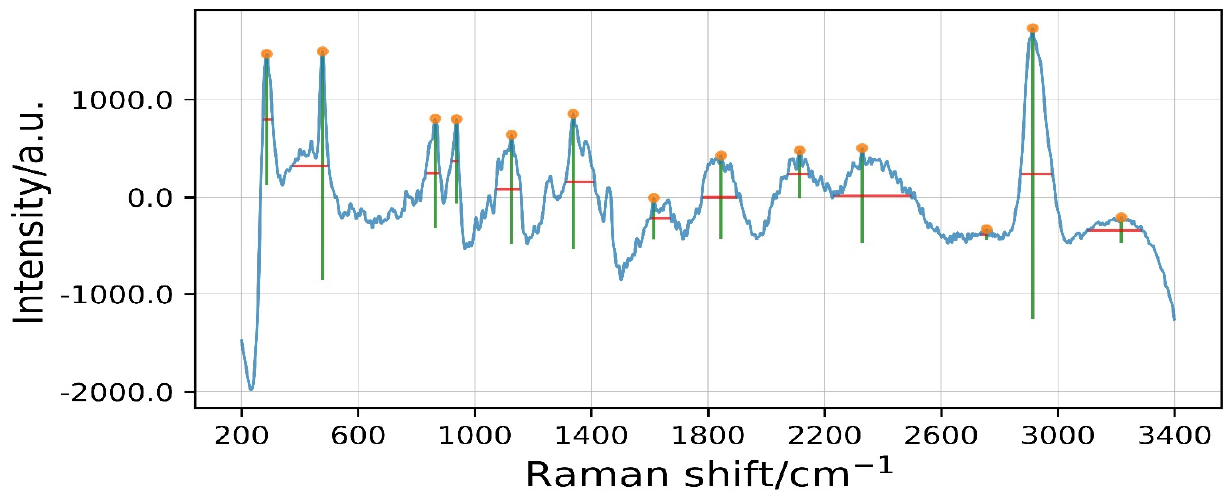
Figure 4. Four-dimensional characteristics of crest. The prominence is the height of the crest, the length of the green vertical line in the figure. The width is the width of the crest, the width of the red line in the figure. The width_height is the height of the crest width, the length from the red line to the peak. The peak_dif is the offset degree of Raman shift.